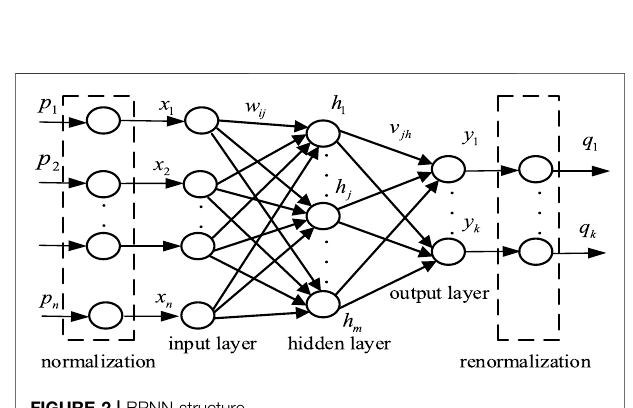
FIGURE 2 | BPNN structure.